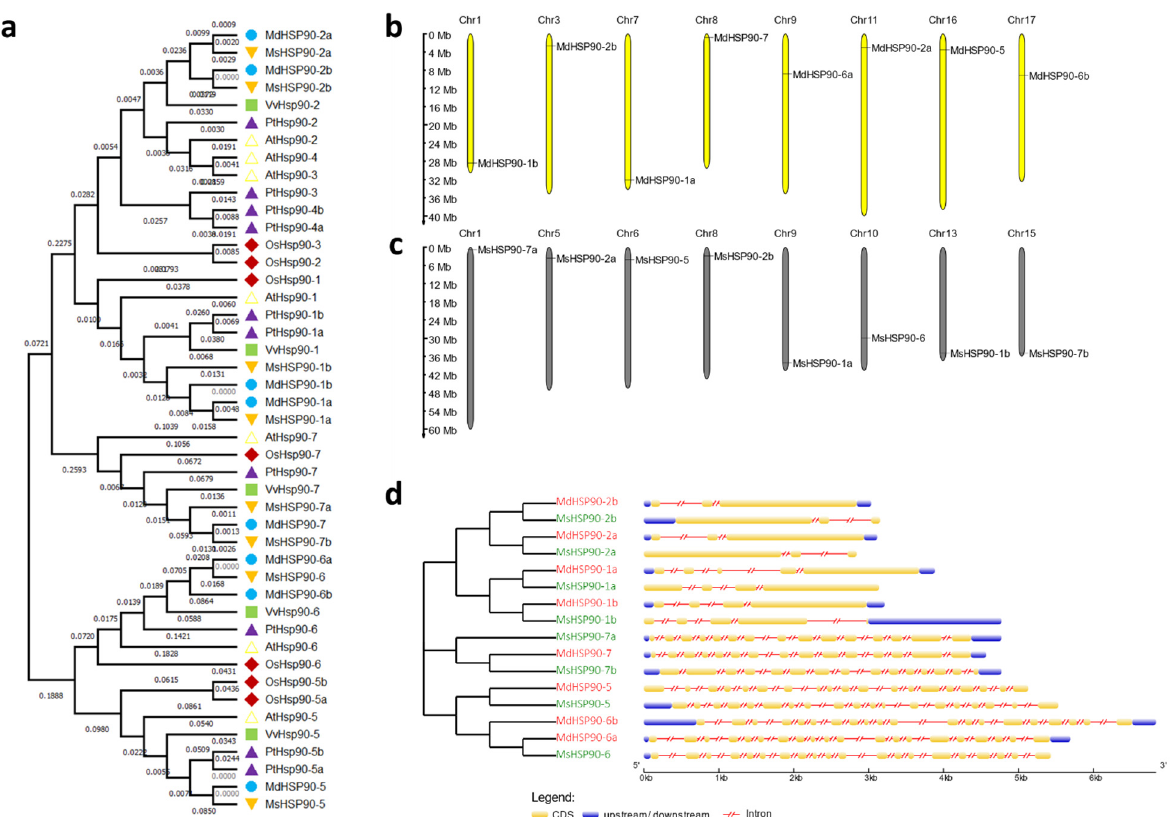
Figure 2. Bioinformatic analysis of HSP90 genes. ( a ) Phylogenetic tree of HSP90 proteins from different species. Protein sequences were aligned by ClustalW algorism, and phylogenetic tree was generated by using the neighbor-joining method with 1000 bootstrap in MEGA X. Different shapes represent different species. Chromosomal locations of the 8 MdHSP90 ( b ) and MsHSP90 ( c ) genes. MG2C online tools were used (http://mg2c.iask.in/mg2c_v2.1/, accessed on 15 May 2021) to depict chromosomal location, and the gene was marked with short lines. ( d ) Gene structure of MsHSP90 and MdHSP90 genes. GSDS2.0 (http://gsds.cbi.pku.edu.cn/, accessed on 15 May 2021) online tools [28] were used to visualize exon–intron structures. Table 1. HSP 90 genes in M. domestica and M. sieversii .